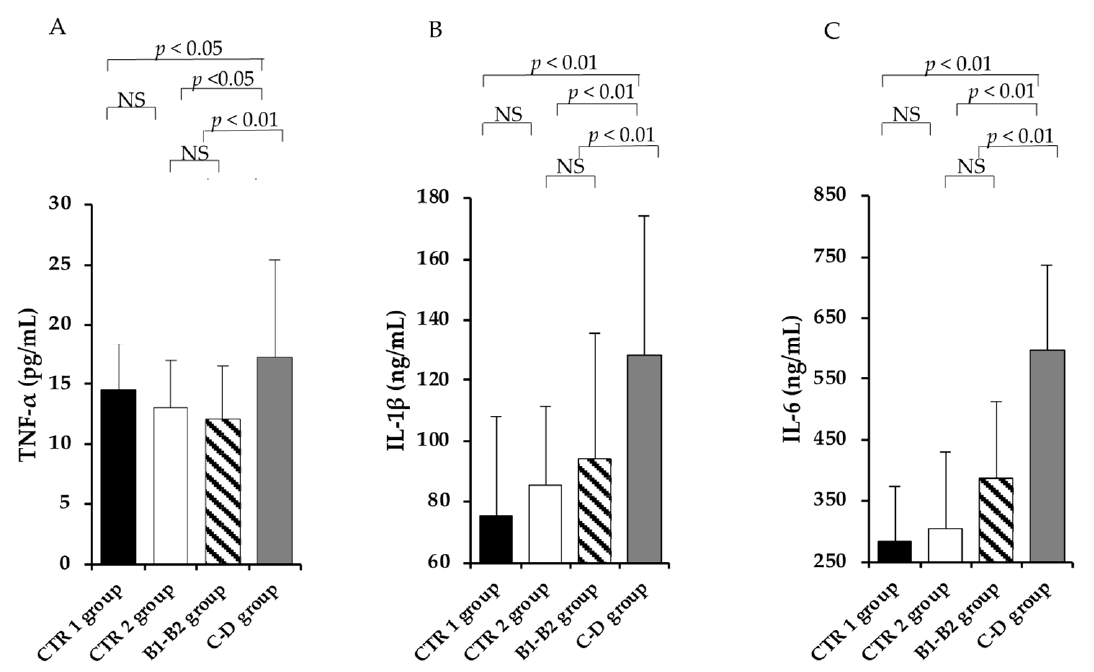
Figure 5. The inflammatory cytokines in enrolled dogs. TNF- α ( A ), IL-1 β ( B ), and IL-6 ( C ) in the healthy young (CTR 1) group (black column), the healthy elderly (CTR 2) group (white column), the mild and moderate MMVD (B1–B2) group (dashed column), and the severe and very serious MMVD (C–D) group (grey column). Wilcoxon’s matched-pairs signed-rank test was performed to compare the different groups. NS means “no significant difference”.